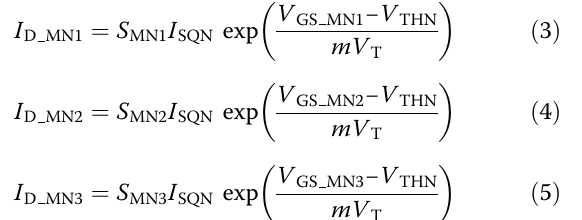
V REF Generating